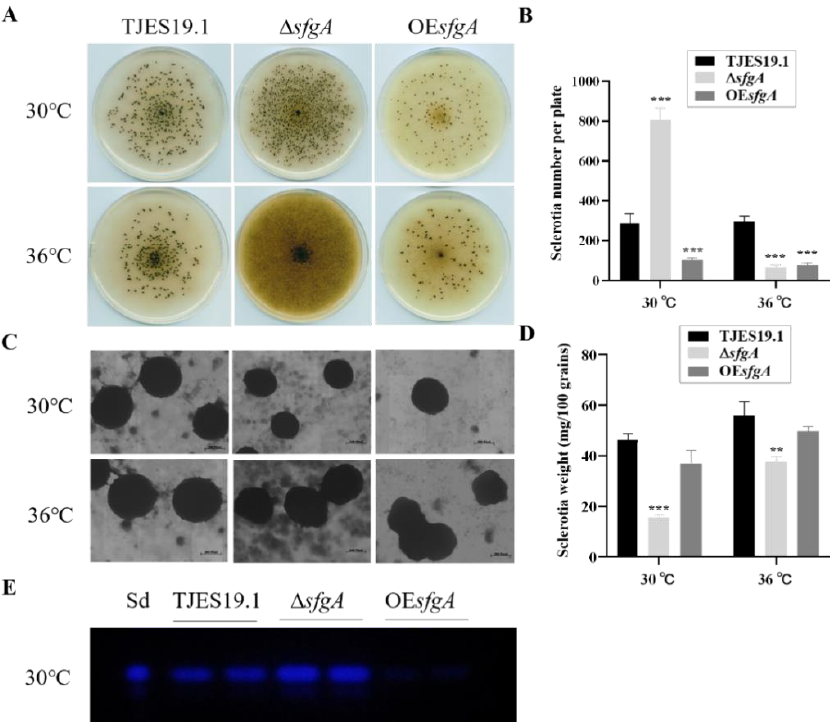
Figure 4. Sclerotia production of ∆ sfgA in A. flavus . ( A ) Ethanol-washed colony photographs of TJES19.1, ∆ sfgA, and OE sfgA strains propagated on solid GMMUU media under dark condition at 30 °C and 36 °C for 14 days. ( B ) Quantitative analysis of sclerotia of strains was conducted. ( C ) Stereo microscope photographs of sclerotia size of TJES19.1, ∆ sfgA and OE sfgA strains; magnification: 50×. ( D ) Weight of 100 sclerotia of strains was measured. ** p ≤ 0.01; *** p ≤ 0.001. ( E ) Aflatoxin B1 produced in sclerotia cultured at 30 °C via thin-layer chromatography (TLC) analyses. Sd represents the AFB1 standard.